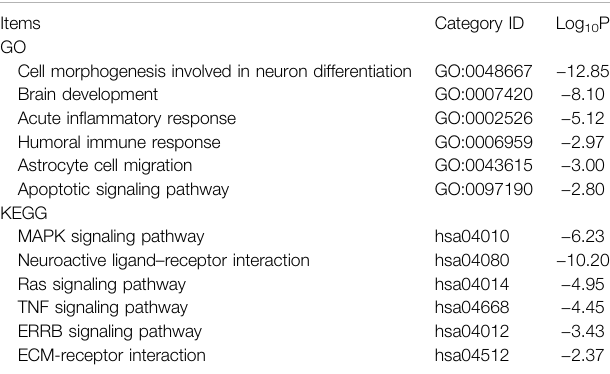
TABLE 4 | GO and KEGG analyses of the protein targets of the fi ve-mRNA signature.